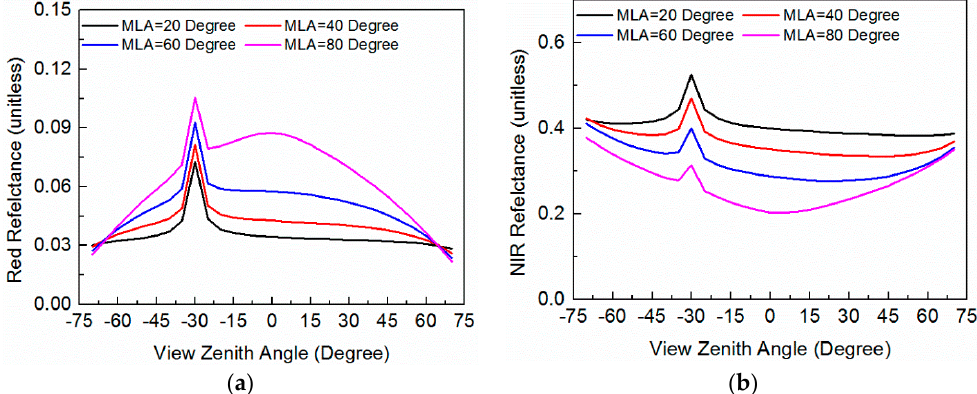
Figure 8. The reflectance simulated by the SIP model in the red band ( a ) and NIR band ( b ) at different mean leaf inclination angles (MLA) in the principal plane. The LAI is 1, and the solar zenith angle is 30°. The other input parameters are the same as Table 1.